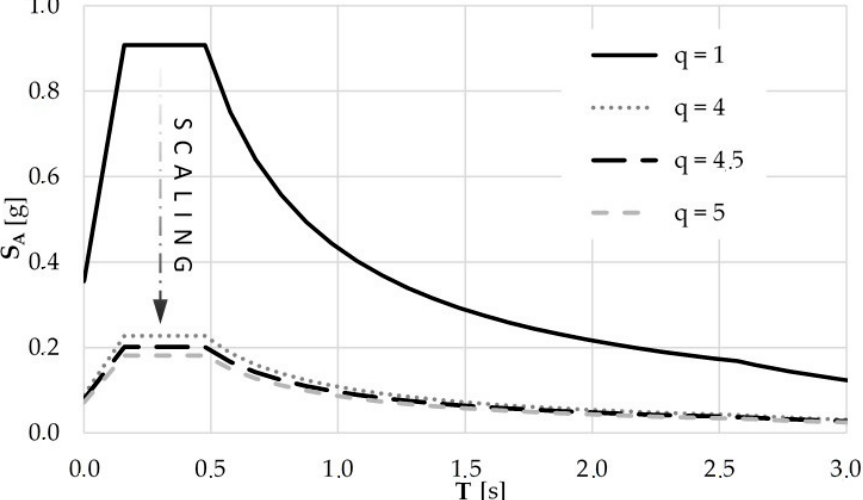
Figure 14. Scaling process of load response spectrum (elastic-Vr of 200 years, soil type C, T 2 h/H of 0.5) for multi-modal pushover analysis method.